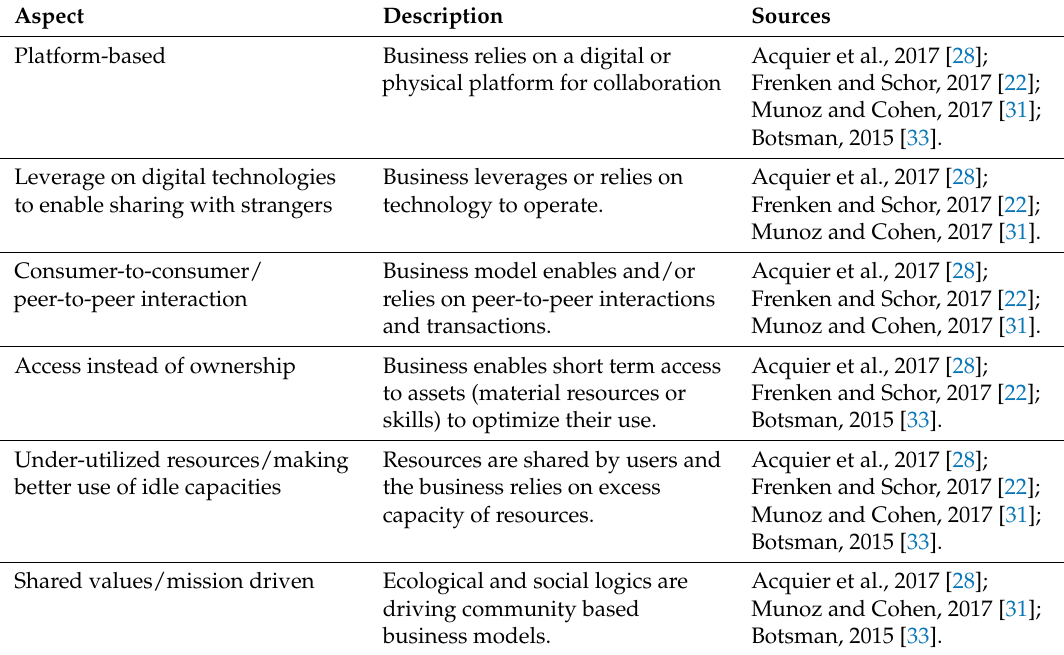
Table 2. Key aspects of the sharing